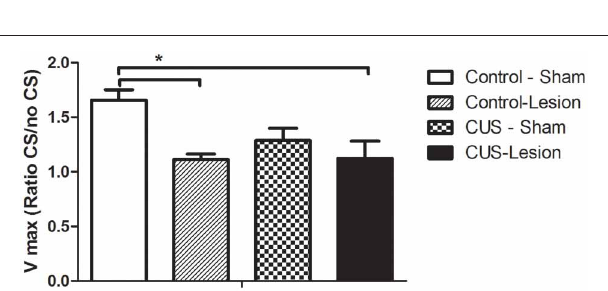
FIGURE 6 | Fear-potentiated startle responses. Startle amplitude in response to an acoustic stimulus. No statistical differences were found between groups. CS, conditioned stimulus; CUS, chronic unpredictable stress rats. Vmax—startle amplitude at 120 db. Results are presented as mean ± SEM. ∗ p < 0 .